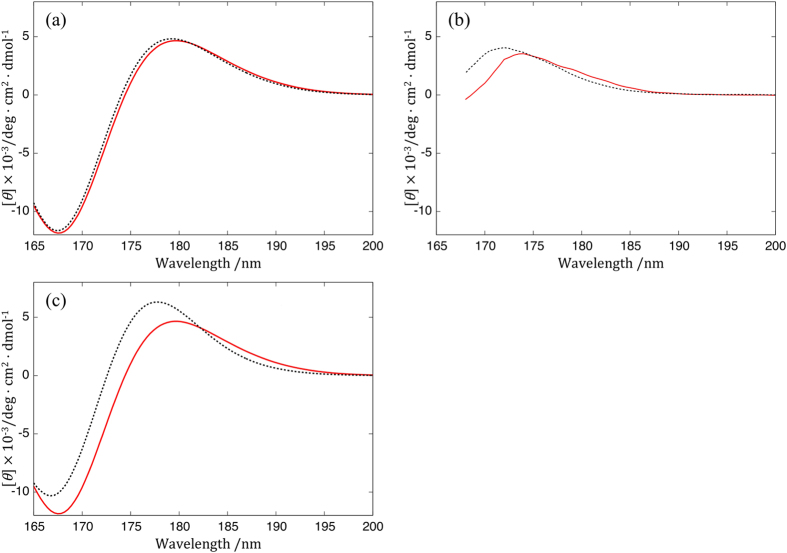
CD spectra of the methyl α-D-Glc (C7H14O6, red) in H2O and its isotopologue (C7H10D4O6, dashed black) in D2O of (a) initial computational prediction, (b) experimental measurement, and (c) revised computation with the scaling of the solvation radius by 1.04.